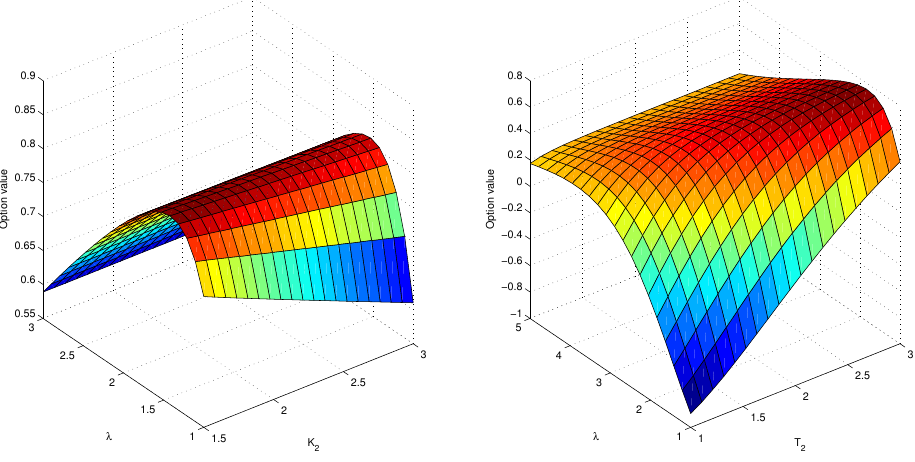
Figure 2. The impact of jump intensity on the option values. Parameters fixed are r = 0.3, σ = 0.4, L = 0.1, M = 1.5, A = 0.02, H = 0.8, S = 1.2, σ J = 0.05, k = 0.4 and t =